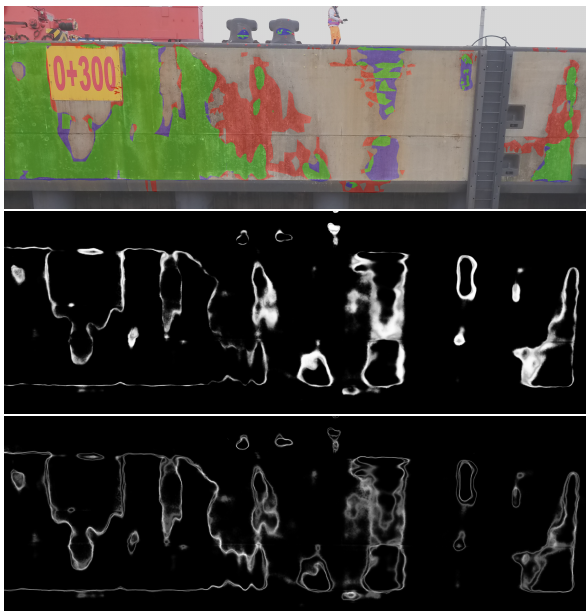
Figure 3. ResNet-50 Deeplab V3+ model’s cropped blending prediction with post-processed colour-coding according to corrosion segments from ground truth data (green: True Positive, blue: False Positive, red: False Negative). Aleatoric and epistemic uncertainty calculated from a related five instance Deep Ensemble